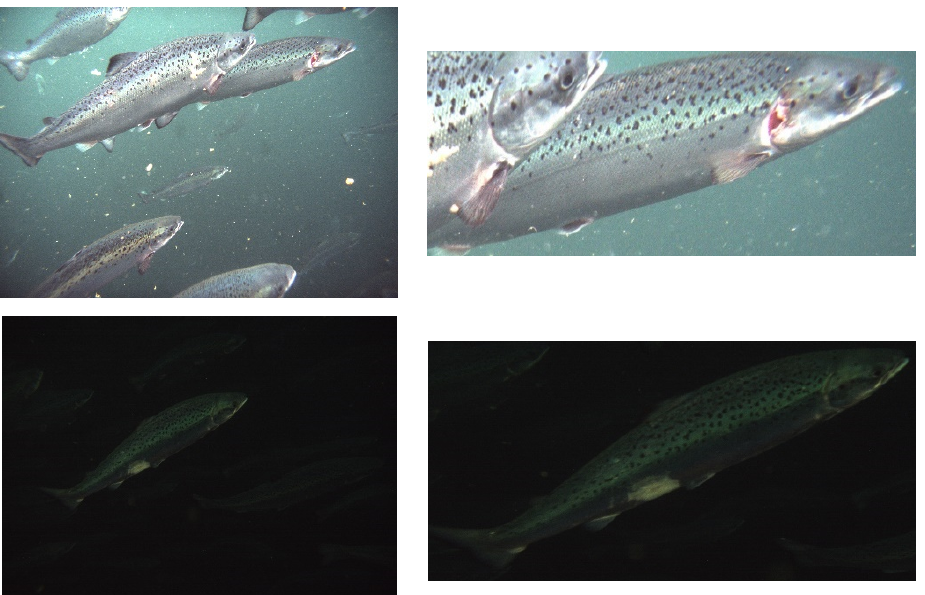
Figure 1. Captured fish images from the live fish tank.